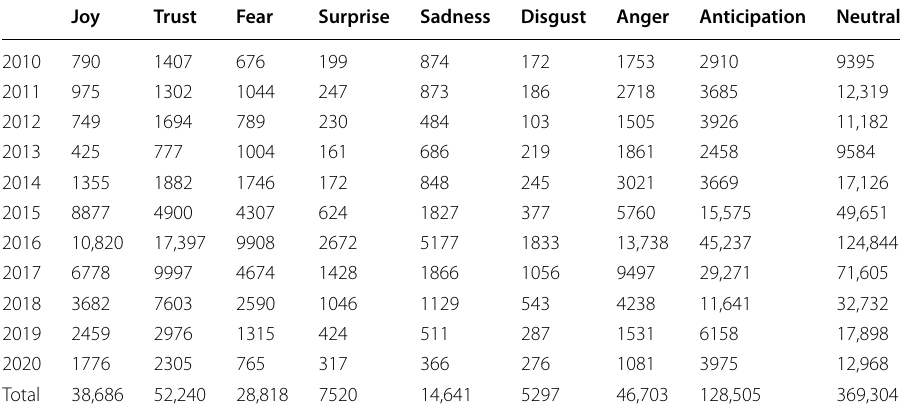
Table 7 Emotion frequency based on the most intense emotion of each tweet for each year over